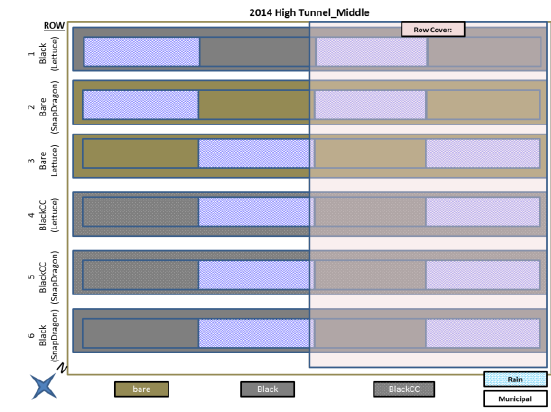
Figure 2. The lettuce production of high tunnels (HTs) in 2011, 2013, and 2014 followed a split-split-plot Figure design.